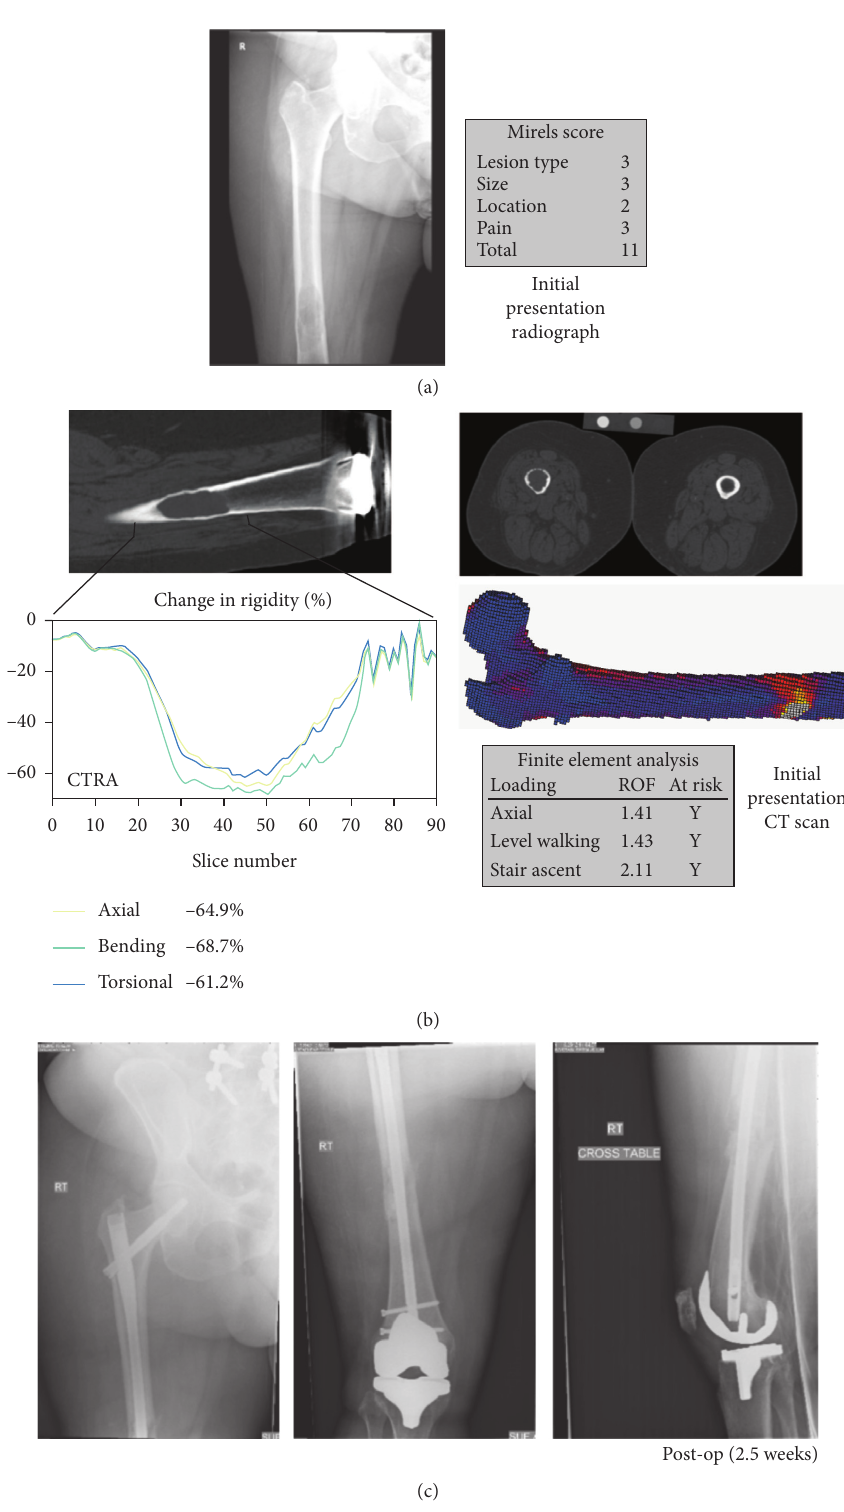
Figure 3: True positive (CTRA+/Fx+) (Case 2, R femur). (a) This is a 77-year-old female with metastatic renal cell carcinoma to the right femoral diaphysis. (b) CTRA and FEA both predicted fracture for this subject. (c) The patient was admitted to the hospital on the day of her initial appointment and twisted her leg in bed, likely causing a fracture. When taken to the OR for prophylactic stabilization, the patient was noted to have a fracture and thus was treated with